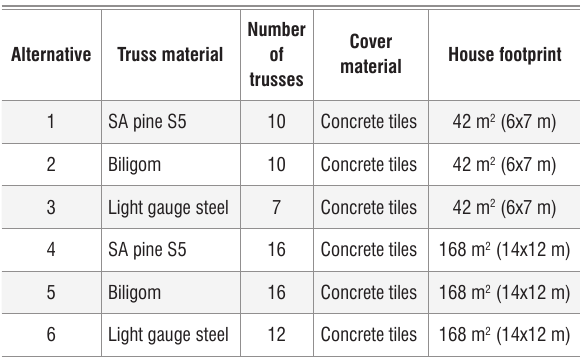
Experimental design